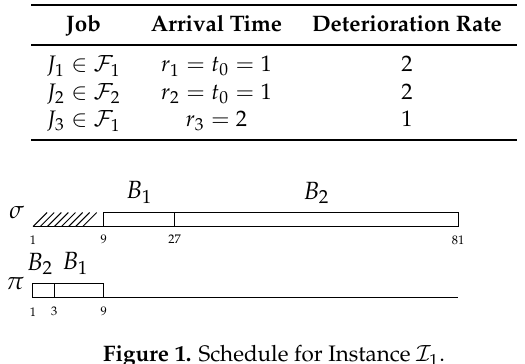
Table 1. Instance I 1 .